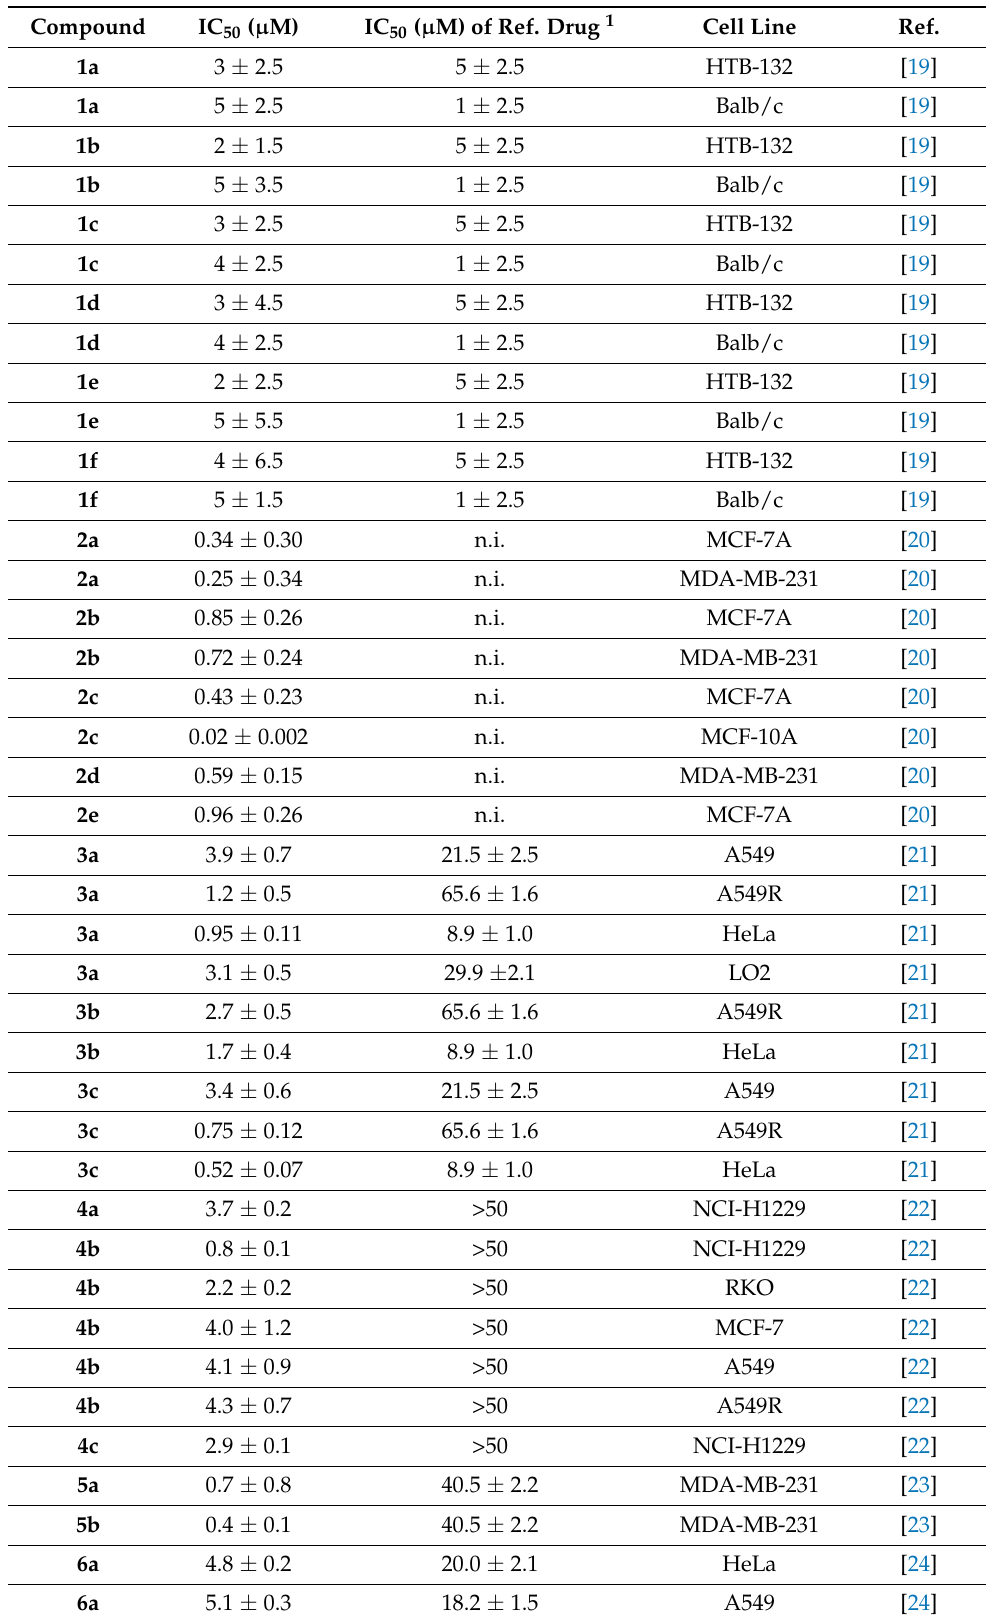
Table 1. IC 50 values of selected anticancer rhenium complexes toward human cancer cell